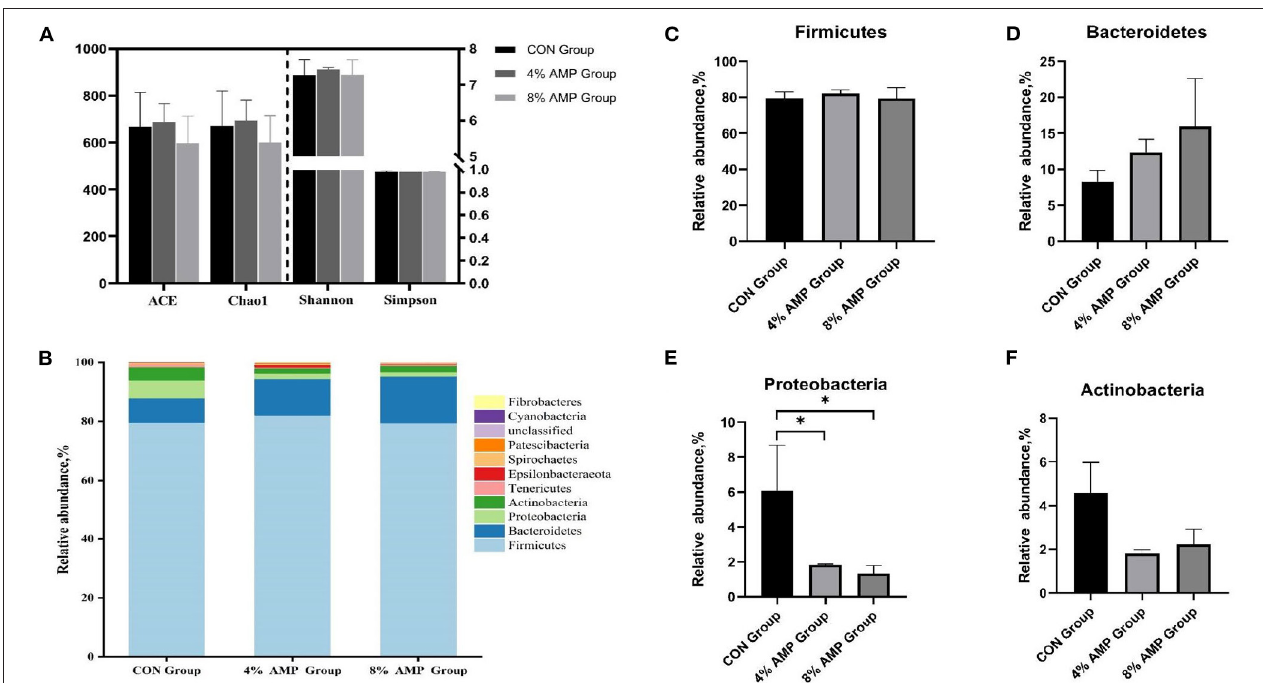
FIGURE 2 | Gut microbiota regulation by AMP at the phylum level. (A) Species diversity and homogeneity were evaluated using the ACE, Chao1, Shannon, and Simpson indices. (B) Relative abundance of cecal microbial phyla. (C) Relative abundance of Firmicutes. (D) Relative abundance of Bacteroidetes. (E) Relative abundance of Proteobacteria . (F) Relative abundance of Actinobacteria . Data are expressed as the means ± SDs, n = 6, * P <